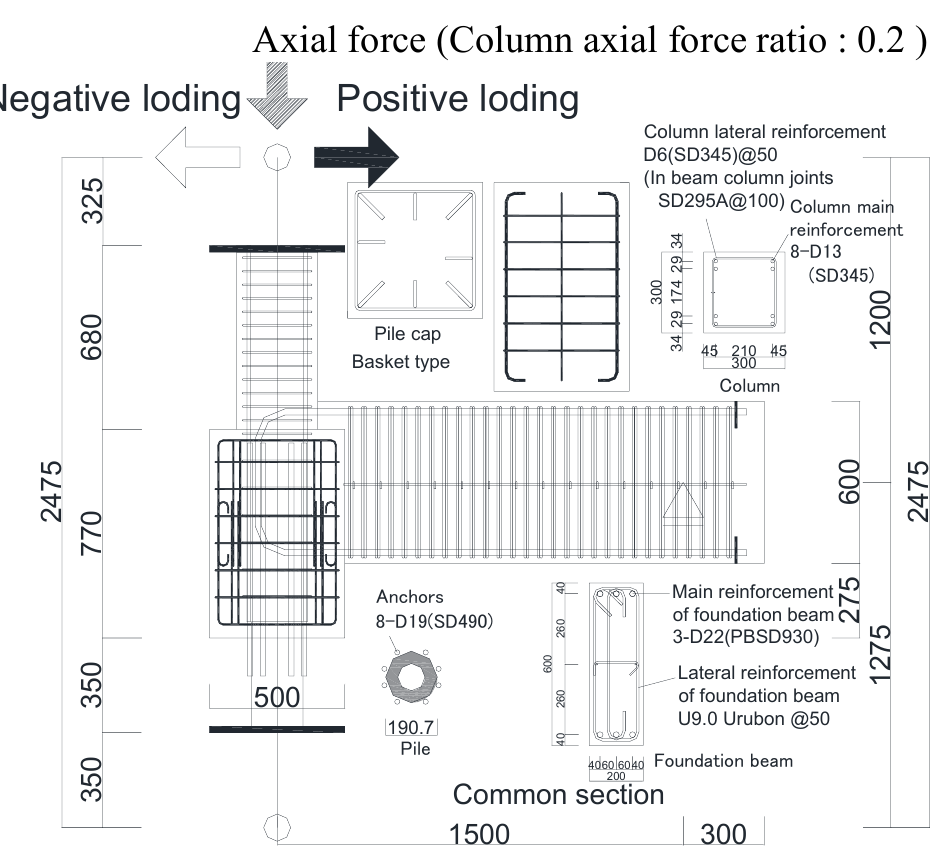
Figure 1. Derails of Specimens.